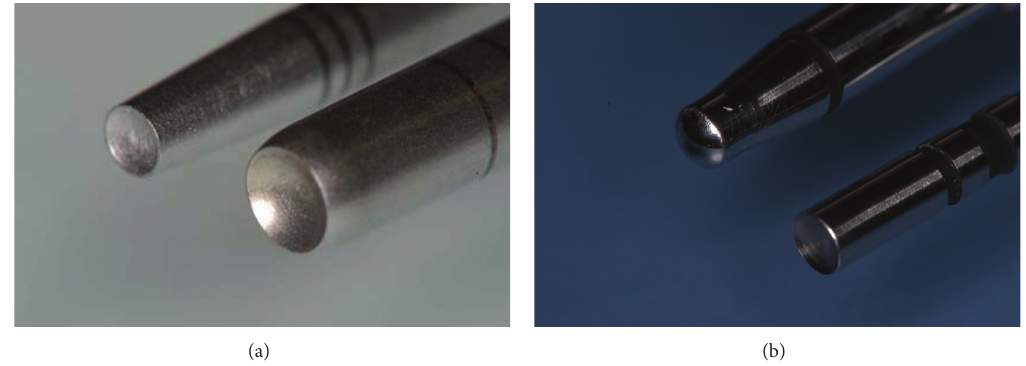
Figure 1: The osteotomes used for the sinus floor elevation. Summers’ (a) and N-type (b)